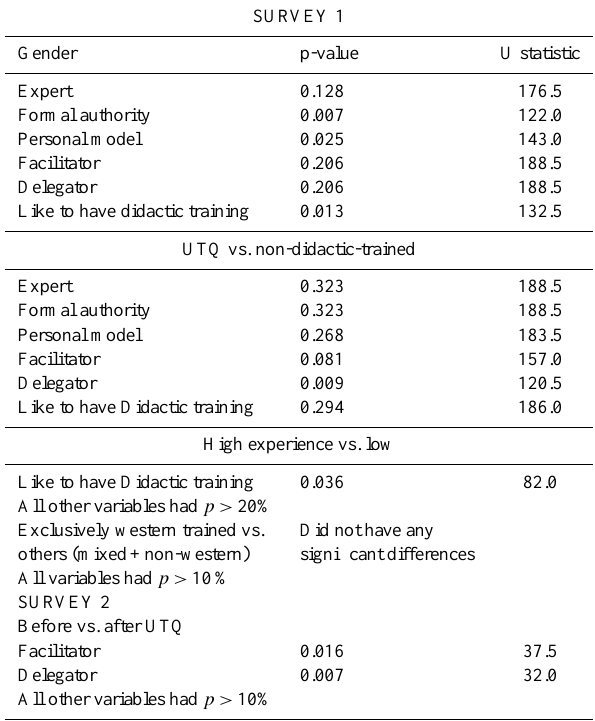
Table A5. Results of the Mann-Whitney